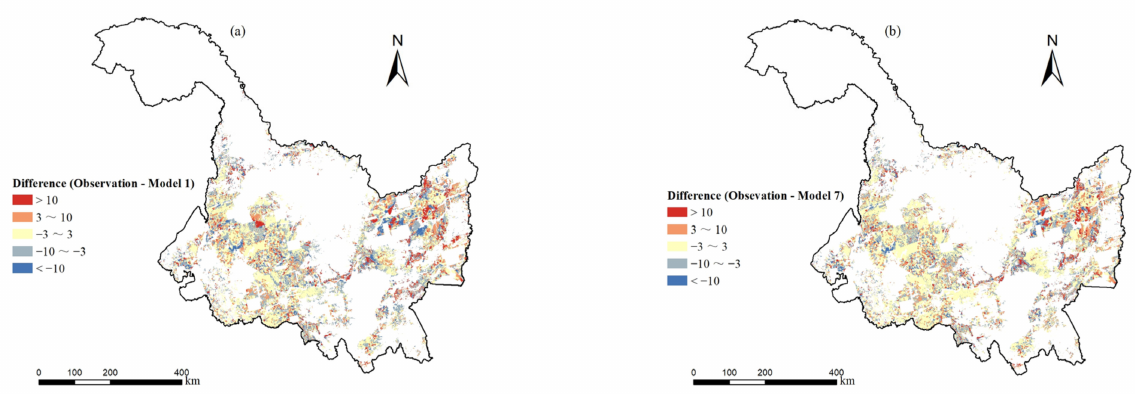
Figure 7. Spatial difference between observation and prediction with Model 1 ( a ) and Model 7 ( b